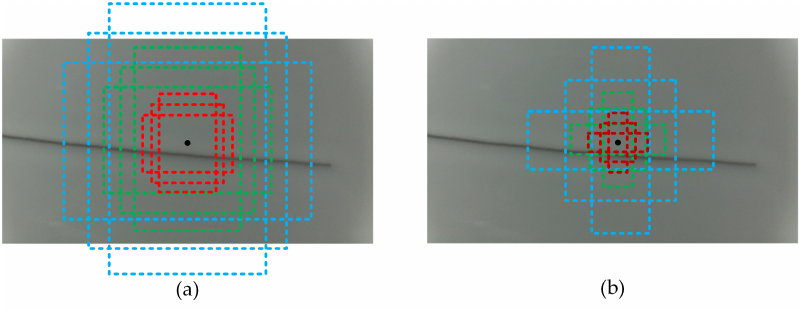
Figure 3. Anchor box comparison. ( a ) Original anchor box, ( b ) anchor box after K-Means